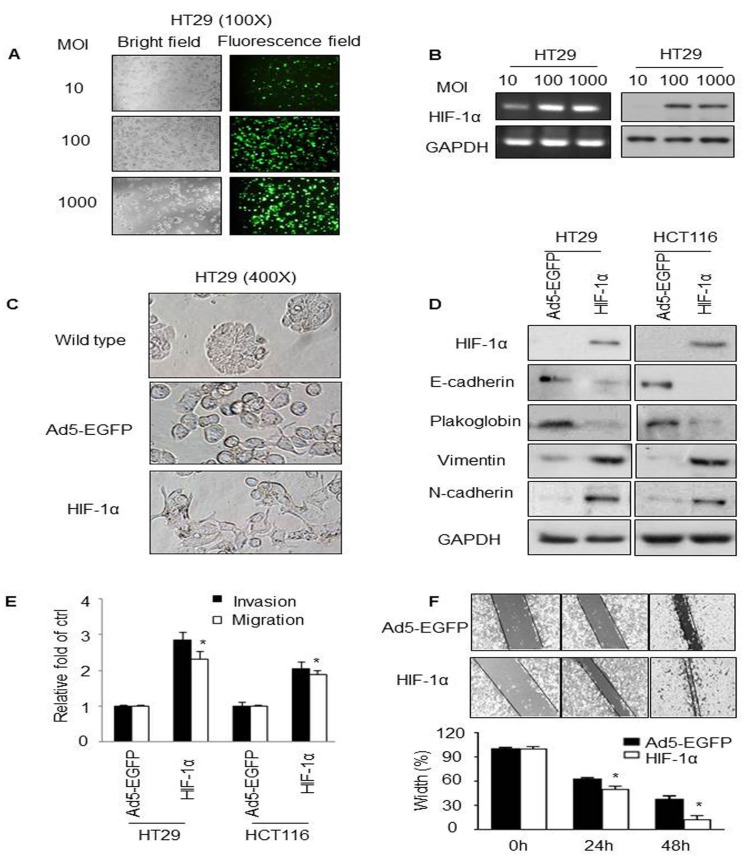
Overexpression of HIF-1α induced EMT and metastasis in CRC cell lines.(A) HT29 cells were transduced with Ad5-HIF-1α at the indicated MOI values for 48 hours. Fluorescence intensity and bright field at the same area were observed at the original magnification as 100X. (B) mRNA (left) and protein (right) expressions of HIF-1α were detected using RT-PCR and western blot, respectively. GAPDH was used as the loading control. (C) Cell morphology of wildtype HT29 or HT29 cells transduced with the indicated adenoviruses (Original magnification = 400X). (D) Western blot analysis of HIF-1α, E-cadherin, Plakoglobin, Vimentin and N-cadherin in adenovirus-infected HT29 and HCT116 cells. GAPDH was used as the internal control. (E) Fold change of invasion and migration in the indicated cells. Quantification of the results was shown in the bar graph with means ± SD. *P < 0.05. (F) Wound healing assay. Cell monolayers were scratched with a pipette tip and images were taken 0, 24 and 48 hours after wound formation. *P < 0.05.